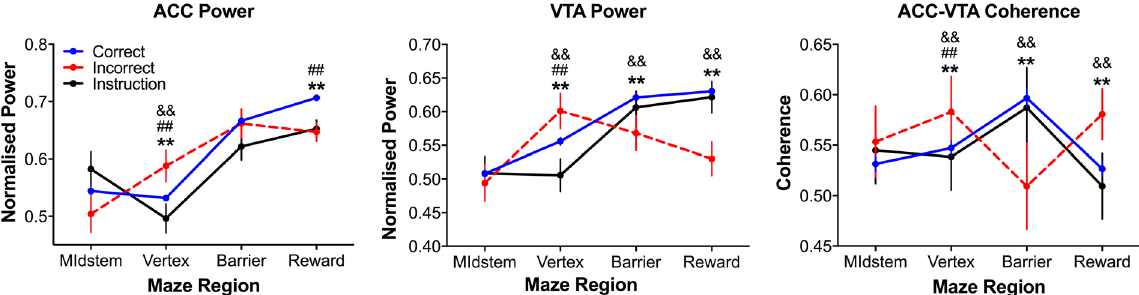
Figure 5. Maze region and trial type dependent changes in 4 Hz power and coherence. 4 Hz ACC-VTA coherence was significantly greater in the reward zone during incorrect trials, as compared to other trial types. These data from phase A1 are presented as mean ± SEM. ** Indicates that correct choices were significantly different from incorrect choices at the p < 0.005 significance level via multiple comparisons tests; && indicates that incorrect and instruction trials were significantly different at the p < 0.005 significance level via multiple comparisons tests; ## Indicates that correct choices and instruction trials were significantly different at the p < 0.005 significance level via multiple comparisons tests. See Fig. S3 for data processed without the regression procedure.